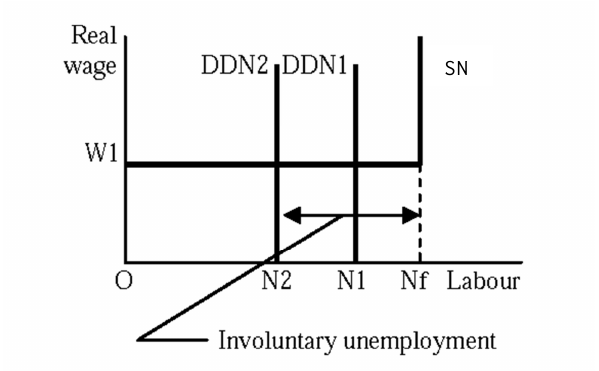
Figure 6. A representation of Keynes’s 1939 model of the labour market